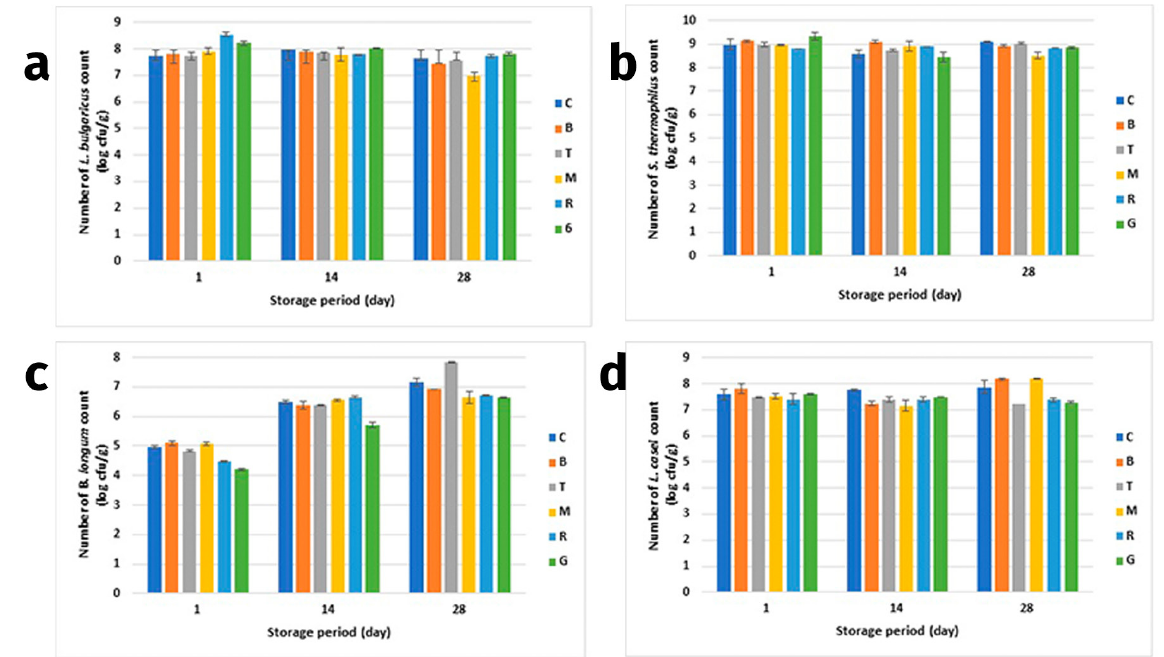
Figure 2. a. Lactobacillus bulgaricus counts of yogurt samples during the storage period; b. Streptococcus thermophilus counts of yogurt samples during the storage period; c. Bifidobacterium longum counts of yogurt samples during the storage period; d. Lacticaseibacillus casei counts of yogurt samples during the storage